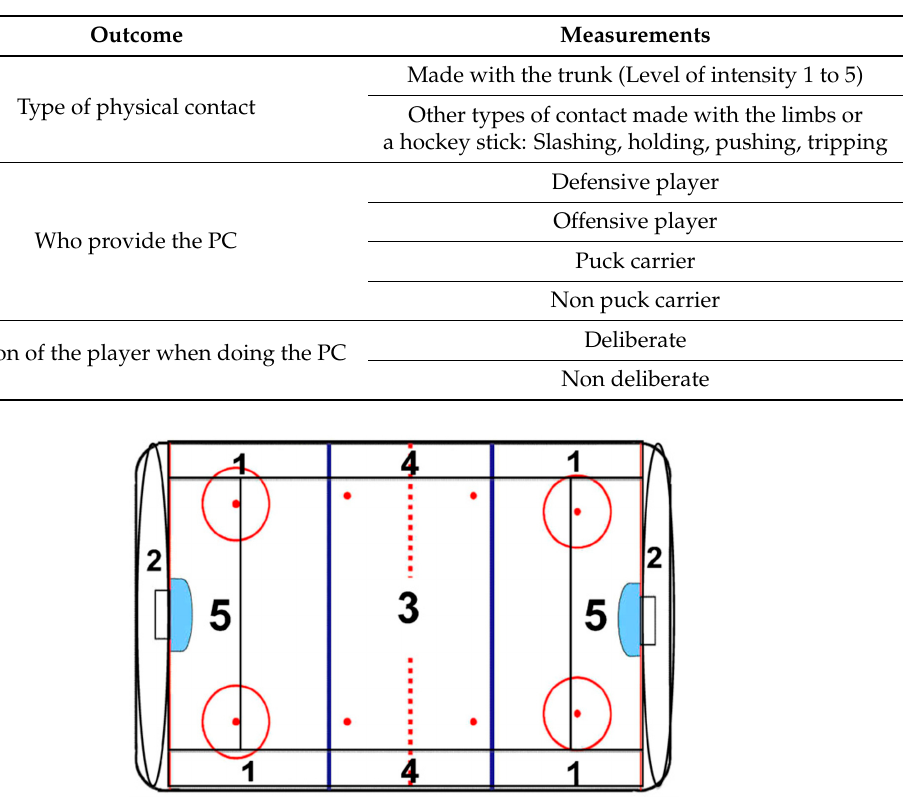
Table 1. Characteristics of the physical contact (PC) observed.